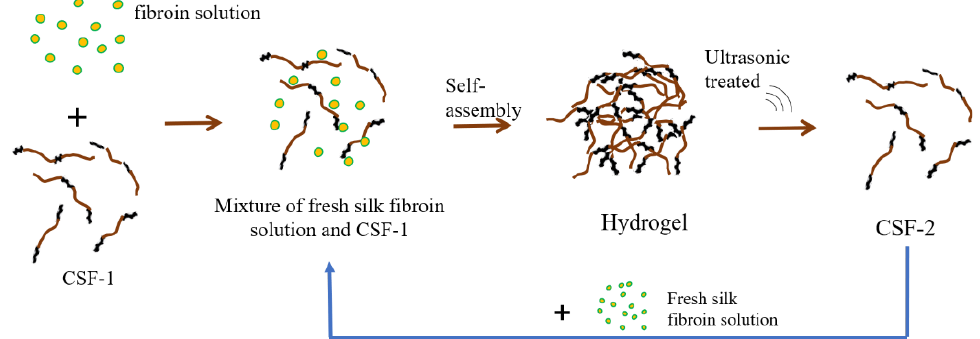
Figure 6. Scheme of the strategy recycling of CSF.